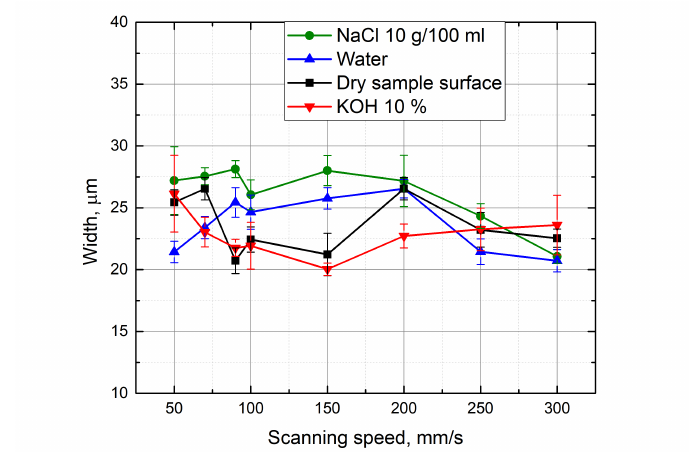
Figure 9. Width of the grooves formed in the glass sample in dependence on the scanning speed. Grooves were formed while the glass sample surface was dry and immersed in different liquids—10% KOH, 10 g/100 mL NaCl solutions, and water. Number of scans—15, average power—5 W, pulse repetition rate—60 kHz.